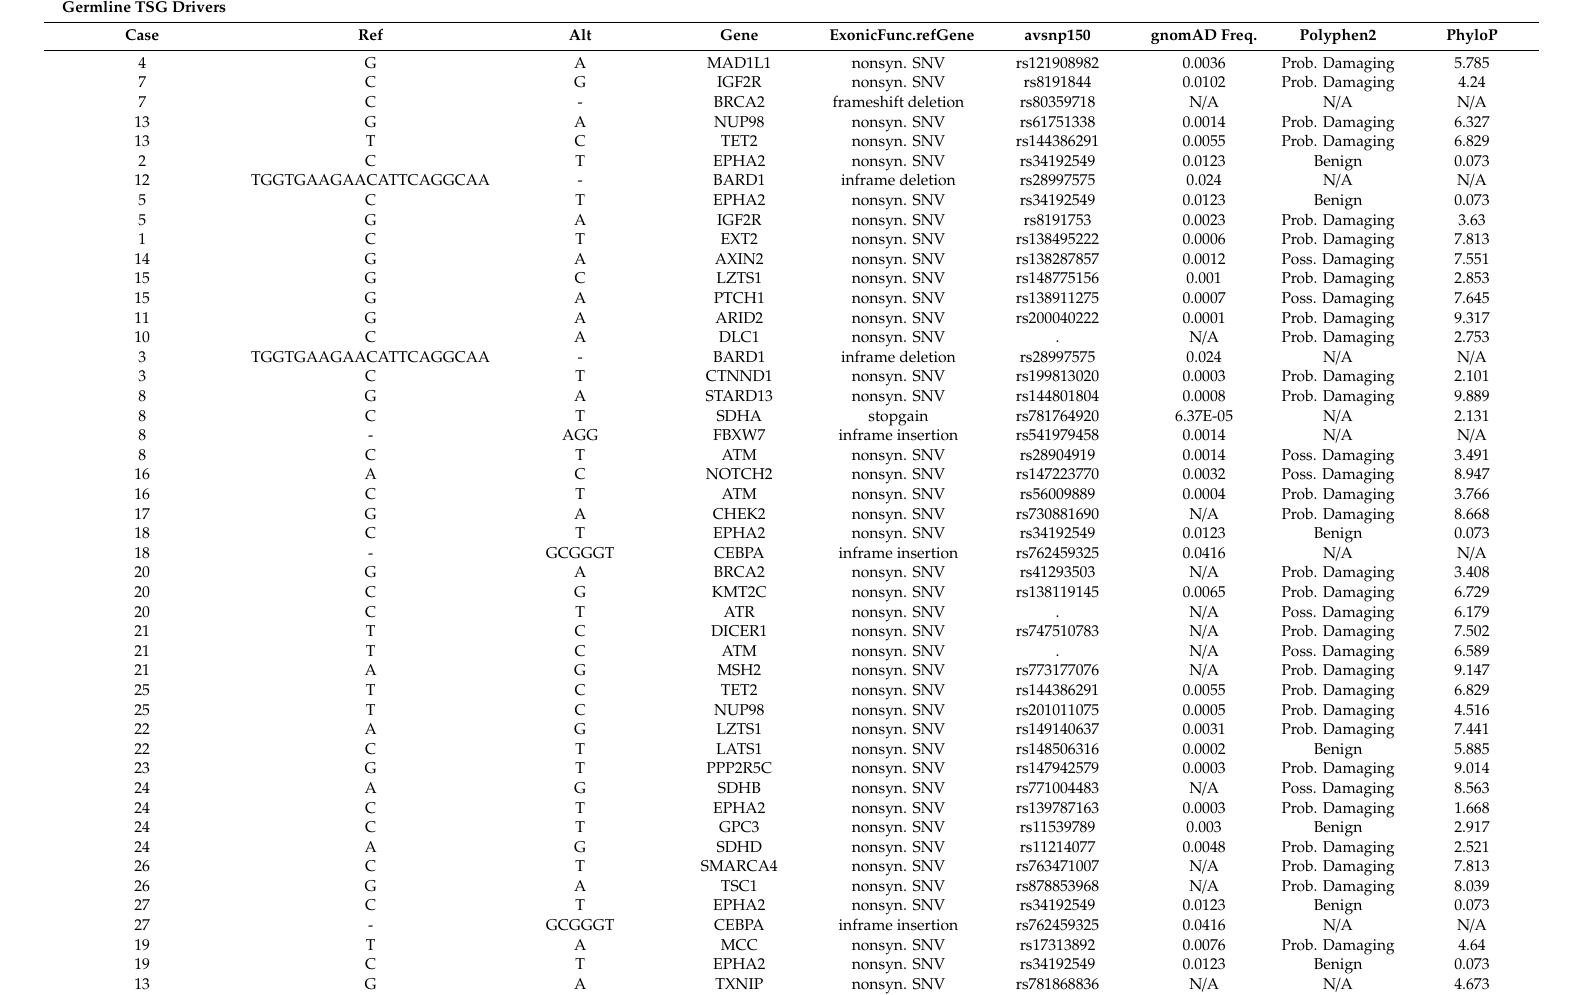
Table 1. Filtered germline and somatic driver